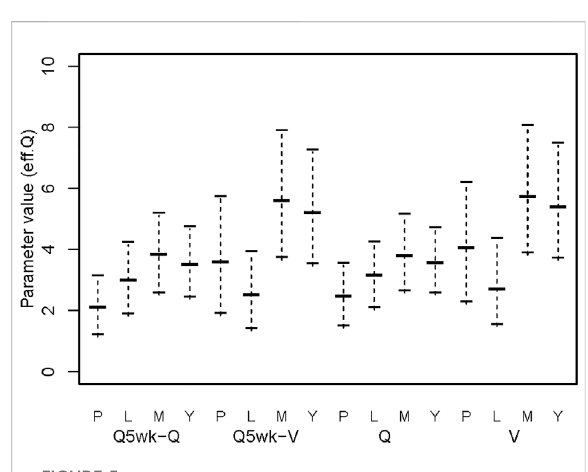
FIGURE 5 Effects of fl ow on spawning probability. The graph shows the estimated parameter values for the effect of fl ow ( eff.Q ) for each site and each of the four models developed. Horizontal bars show the median parameter estimate with whiskers encompassing the 95% credible interval for the estimate. Sites are arranged from upstream to downstream (P = Pyke Road, L = Loch Garry, M = McCoy ’ s Bridge, Y = Yambuna). The fi rst two sets of results are those that included antecedent fl ows ( Q 5 wk ) as an additional driver of spawning; the second two sets of results did not include Q 5 wk . Q implies that fl ow effects were modelled using discharge; V implies that reach-averaged velocity was